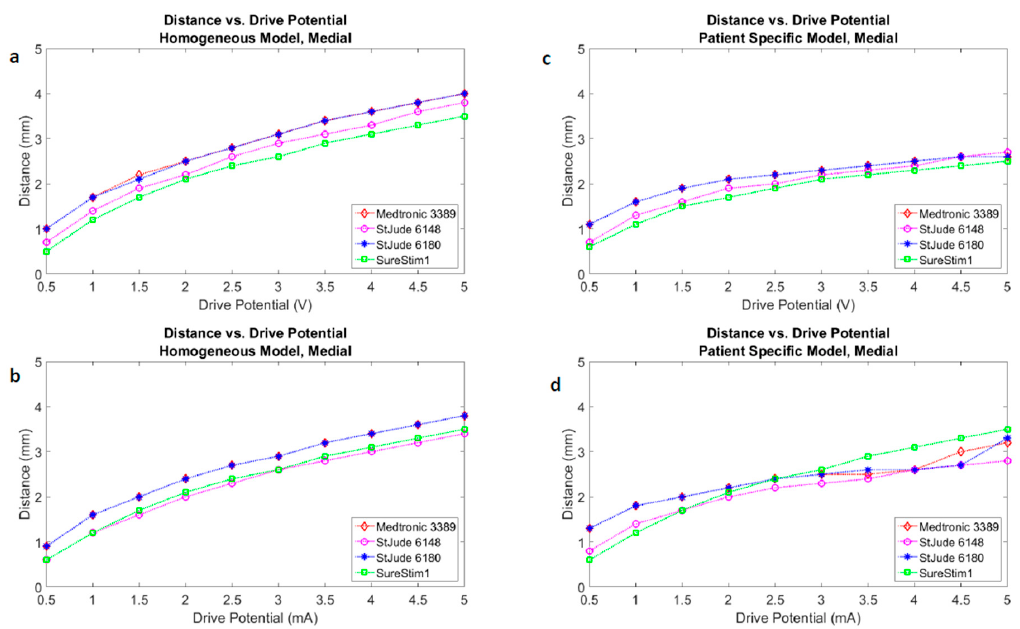
Figure A3. Neuron modelling: Distance vs. drive potential. Medial